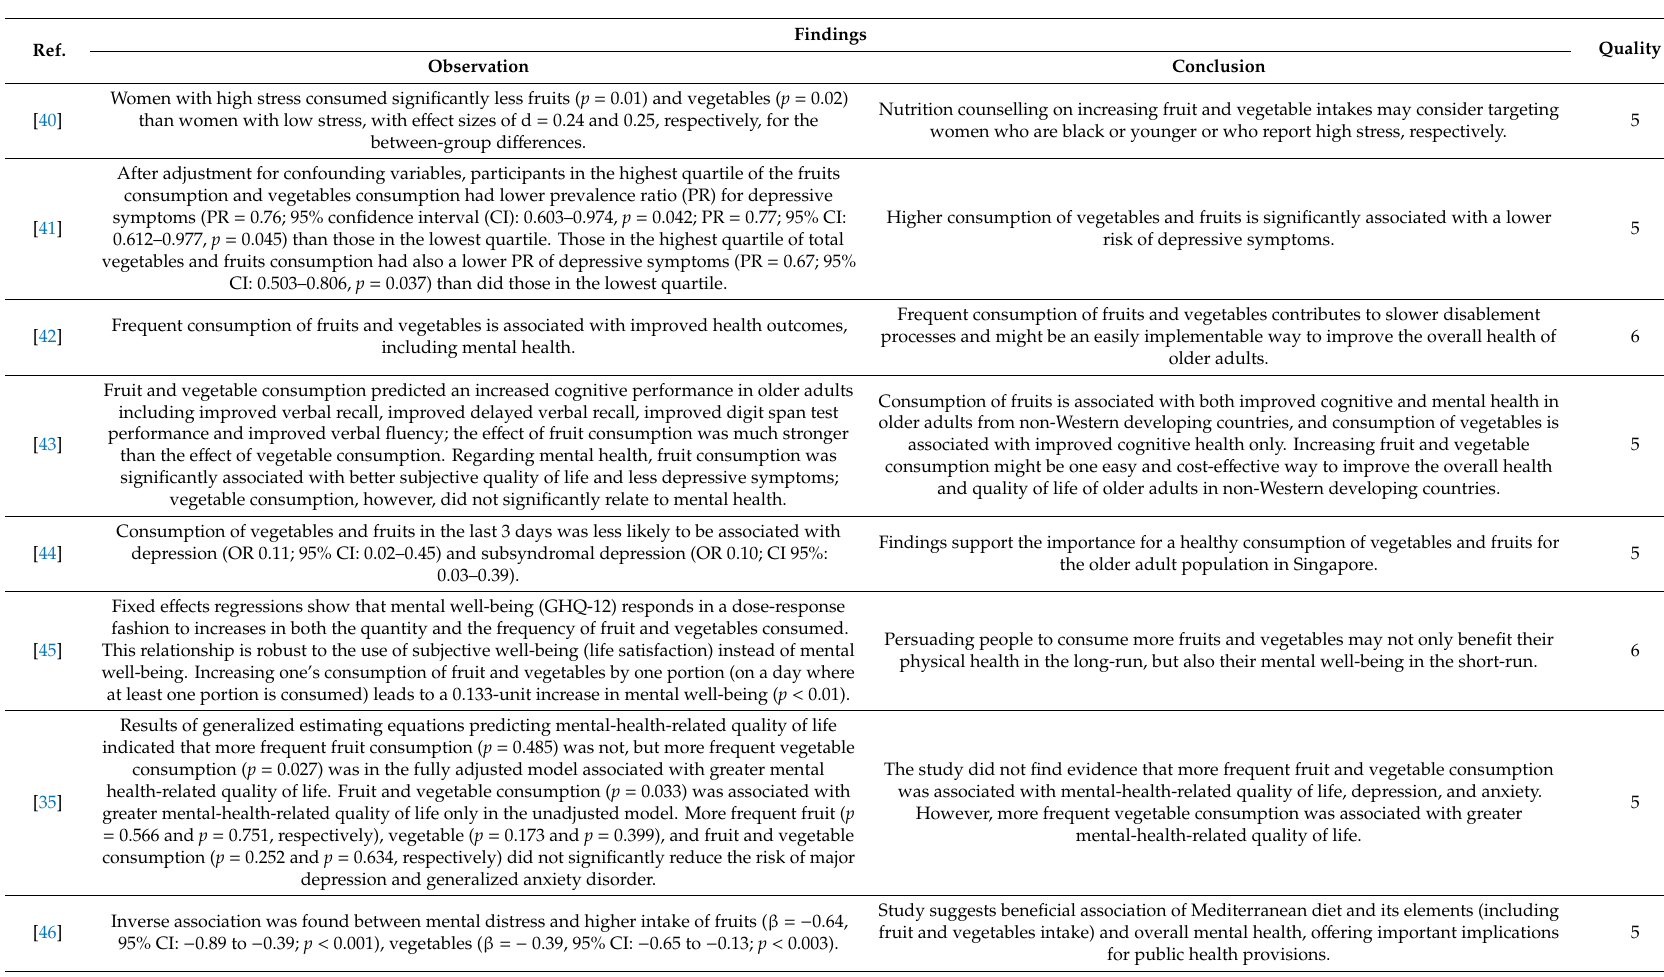
Table 3. Characteristics of the study findings for the studies included to the systematic review accompanied by the quality assessment based on the total score for the Newcastle–Ottawa